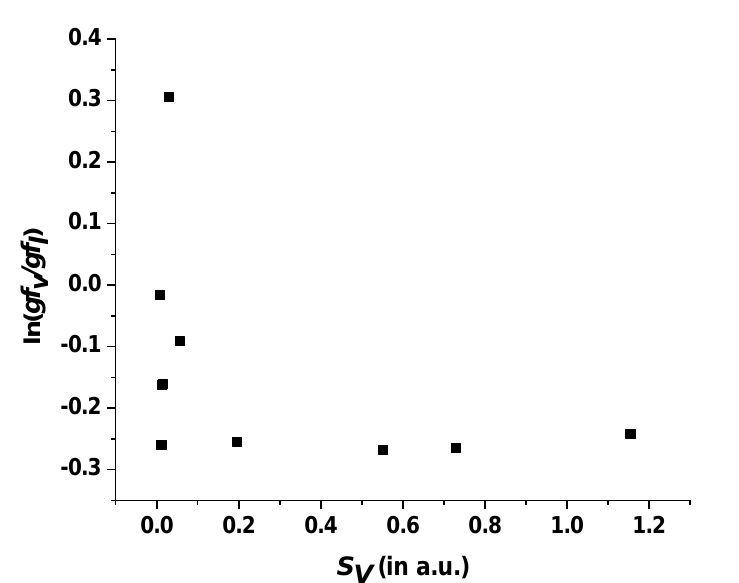
Figure 2. A comparison of the length and velocity forms of oscillator strengths for a few of the strongest transitions of W 11+ .